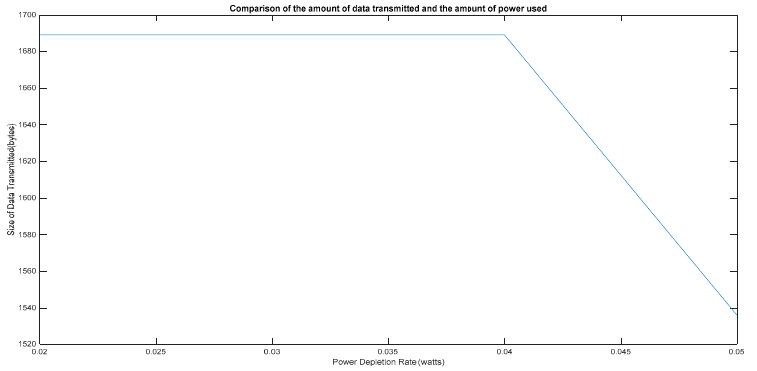
Figure 14. Turnaround time vs. packet transmission rate at zero power state comparison.